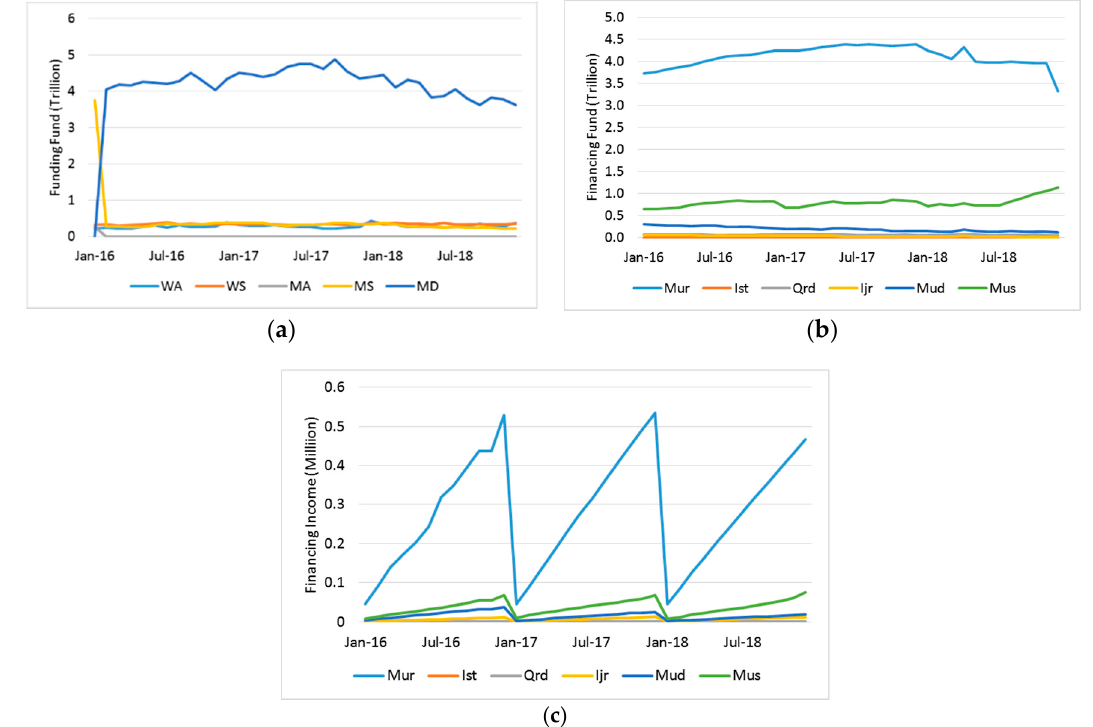
Figure A1. ( a ) Funding fund, ( b ) Financing fund, ( c ) Financing income from Bank A.